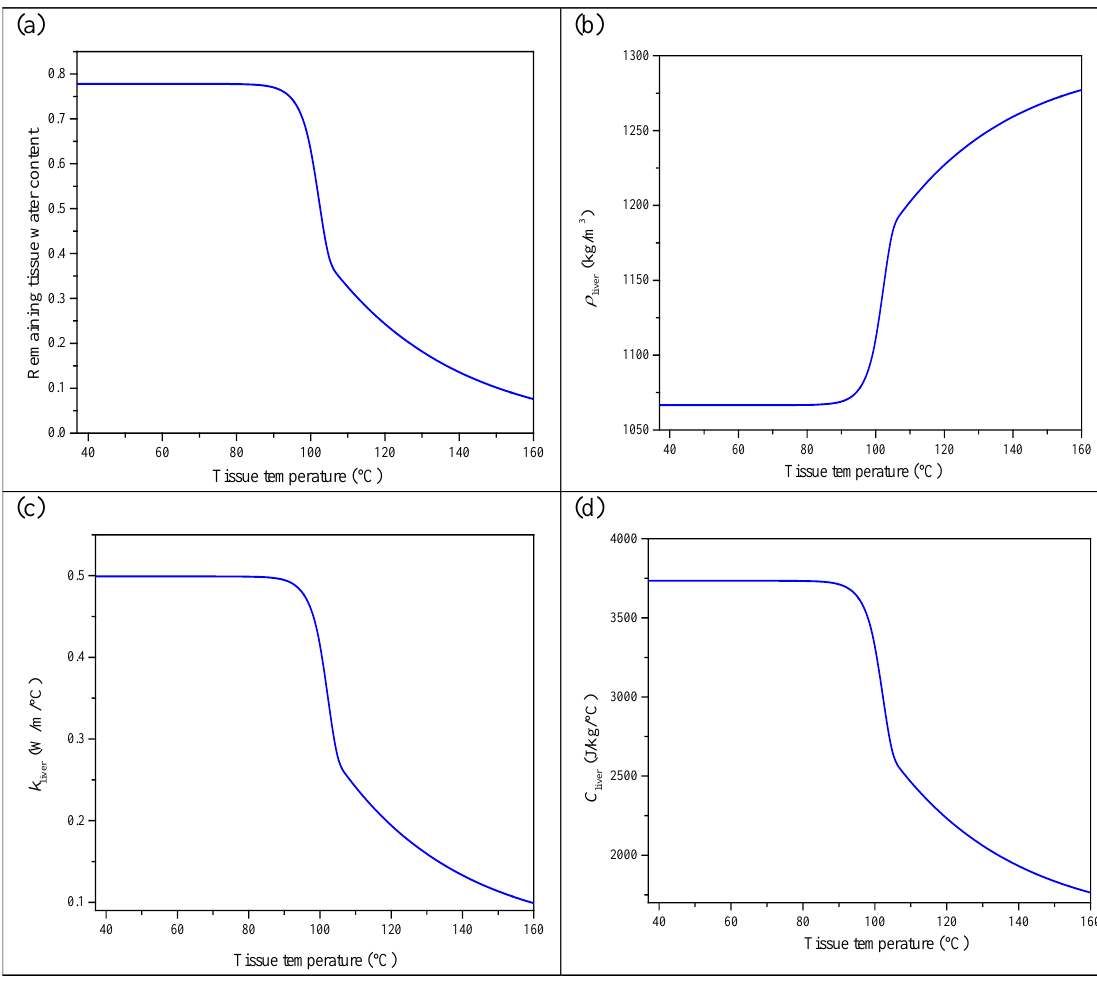
Figure 1. Evolution of thermal properties versus the temperature. ( a ) Remaining mass of tissue water W a ( T ) , ( b ) density of the liver tissue ρ liver ( T ) , ( c ) thermal conductivity of the liver tissue k liver ( T ) , and ( d ) specific heat of the liver tissue C p , liver ( T ) .